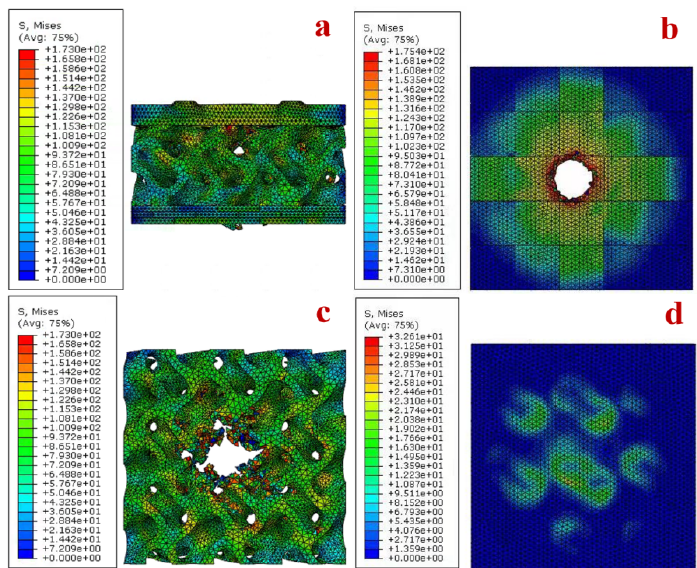
Figure 4. The stress cloud diagram of the B-B-C composite structure and its components. ( a ) B-C-C composite structure. ( b ) Plate B. ( c ) Core C. ( d ) Backplate C.